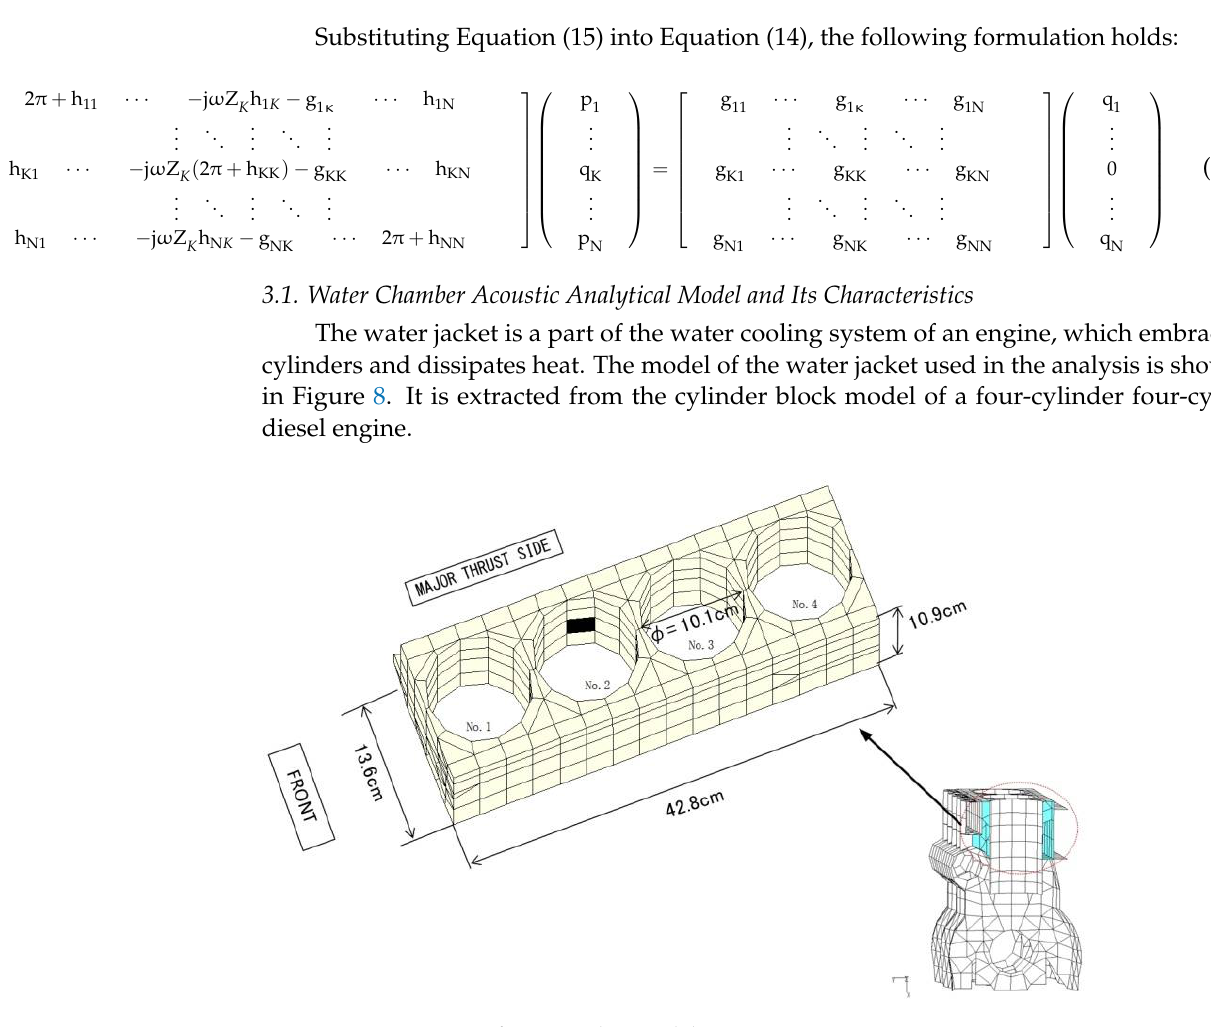
Figure 8. Appearance of water jacket model. acceleration excitation is applied at the center of the No. 2 cylinder with a sweep frequency from 100 to 3000 Hz. Figure 9 shows the frequency response and the corresponding modes of the water jacket model. Blue arrows represent the absolute value of pressure, and color distribution indicates the phase. The figure indicates that there are four resonance frequencies, namely 1513, 2271, 2740 and 2953 Hz, and the corresponding sound pressure distributions are the first mode of Z-axial direction, the first mode of Y-axial direction, the first mode of Z-axial and Y-axial directions combined and the second mode of Z-axial direction. Additionally, we focus on the frequency response characteristics; factors of attenuation (such as impedance boundary) are not considered in this part. Theoretically, the sound pressure at each resonance point diverges to